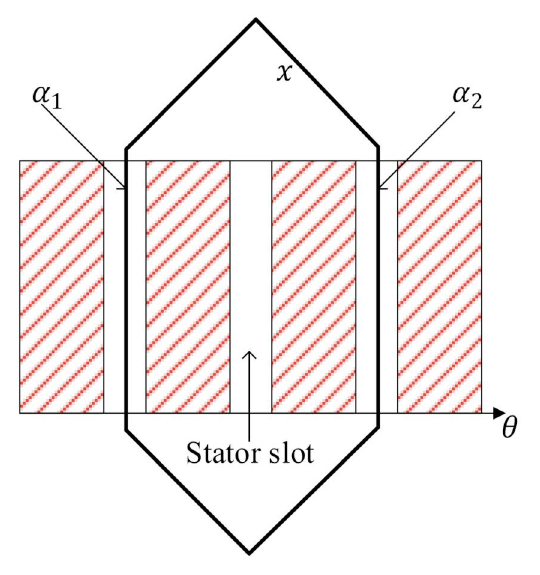
Figure 7. Mechanical angle of the stator winding